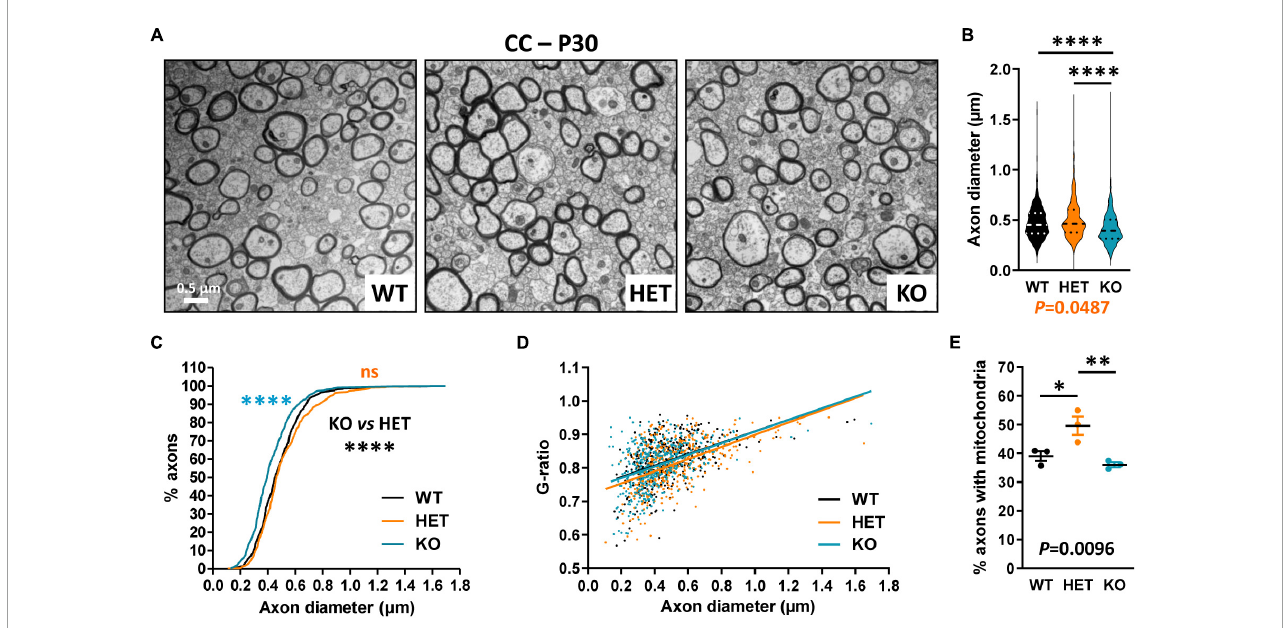
FIGURE4 Ultrastructural abnormalities of corpus callosum (CC) myelinated fibers in P30 mice. Electron micrographs of transversal sections of the CC at brain midline, from wild-type (WT), HET, and KO P30 mice (A) . Axonal diameters of CC myelinated fibers (B) . Cumulative frequency distribution of axonal diameters (in %) (C) . Scatter plot graph displaying G-ratios of individual myelinated axons as a function of the respective axon diameters, and linear regression of the G-ratio measurements for each genotype (D) . Percentage of myelinated axons containing mitochondria (E) . (B–D) 450 myelinated fibers/genotype, 3 mice/genotype, 150 myelinated fibers/mouse; (E) 3 mice/genotype, % of mitochondria counted on ∼ 2000 axons/mouse. Statistical tests: (B) Mann–Whitney test to compare HET or KO mice to WT mice, and Kruskal–Wallis test to compare the three genotypes; (C) Kolmogorov–Smirnov test for pairwise comparisons; (D) Linear regression (WT R 2 = 0.2102, HET R 2 = 0.2871, KO R 2 = 0.1959) for pairwise comparisons, HET vs. WT elevation P < 0.0001, HET vs. KO elevation P = 0.0005; (E) Unpaired t -test to compare HET or KO mice to WT mice,